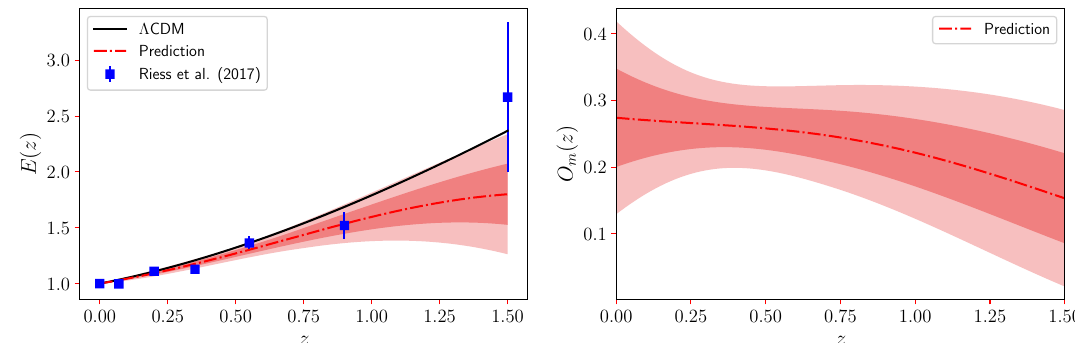
Fig. 3 Left panel: reconstruction of the E ( z ) function from the Pantheon sample. Right panel: reconstruction of the O m ( z ) diagnostic test function from the Pantheon sample. The black line represents (cid:4) CDM model from Planck-CMB values